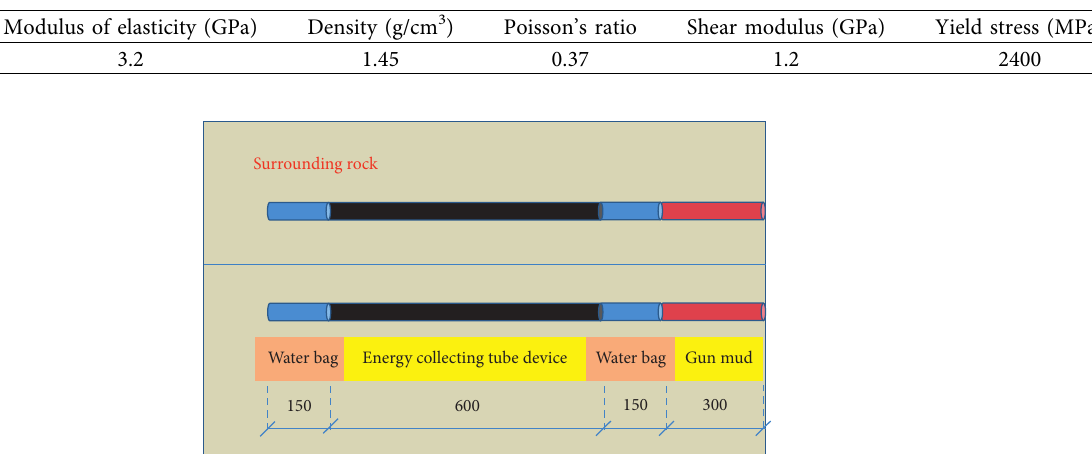
Figure 9: Schematic diagram of gun mud-accumulating charge